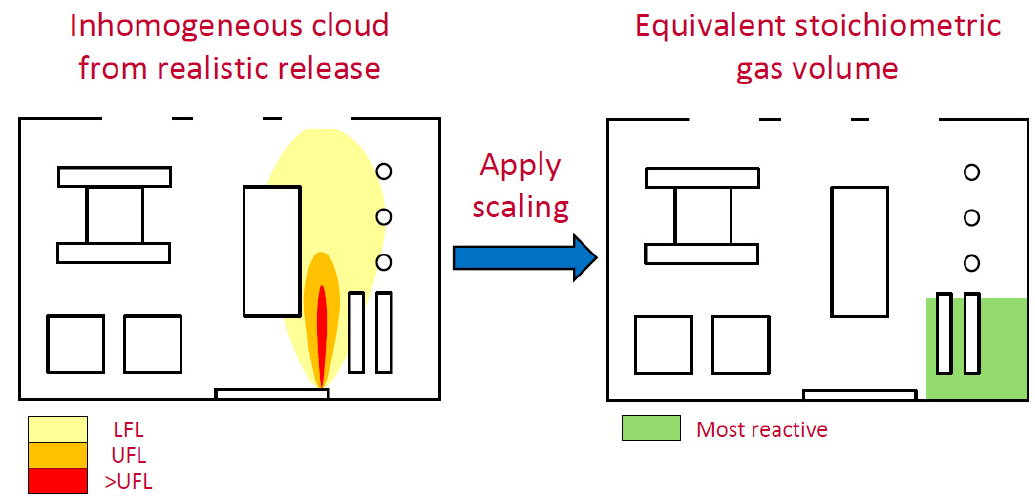
Figure 1. The representation of a complex flammable gas cloud with a simple gas cloud with uniform concentration in a quiescent state (courtesy of J Stewart, Health and Safety Laboratory) .